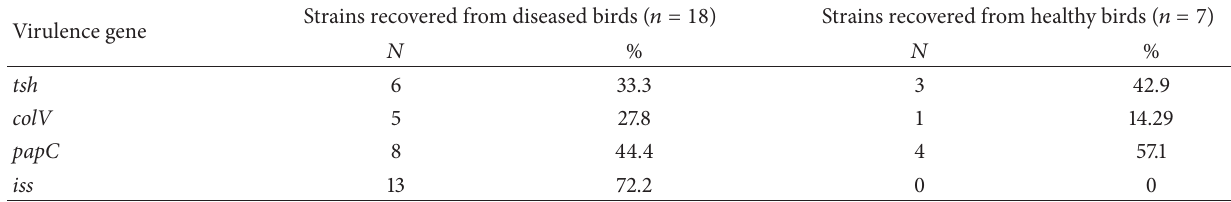
Table 2: Distribution of virulence-associated genes in strains recovered from diseased and healthy birds. Virulence